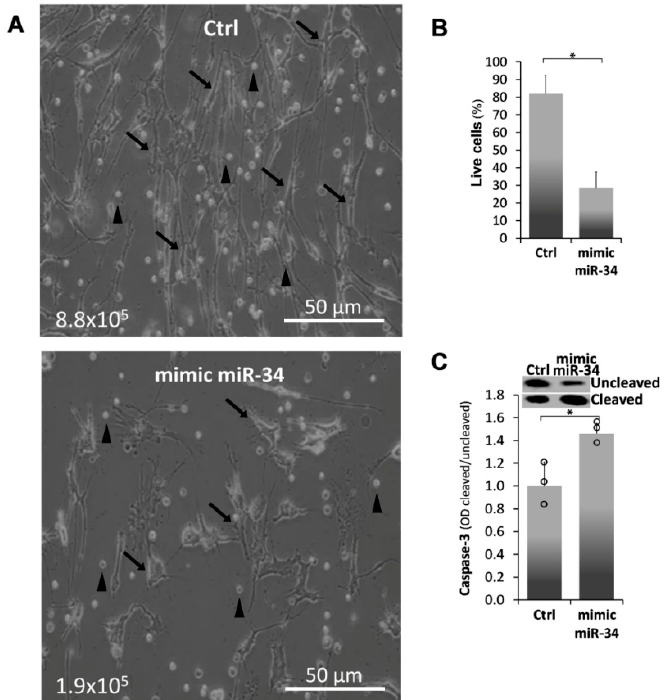
Figure 3. Mimic miR-34a increases cell-death in human IPF-lung fibroblasts Work flow; fibrotic-lung myofibroblasts (ATCC-CCL-191) were transfected with mimic miR34a (5 nM, 72h, Trans-iT) vs. control (NC) and then co-cultured with Jurkat T cells. ( A ) Microscope images with trypan-blue exclusion (arrows denote myofibroblasts; triangles, lymphocytes) ( B ), graphical presentation of cell survival percentage and ( C ), Graphical presentation of cleaved / uncleaved caspase-3 ODs (Upper panel) and Wb (insert). Representative results from three independent experiments. Error bars represent mean ± SD; circles represent individual data points. * p < 0.01–0.05.